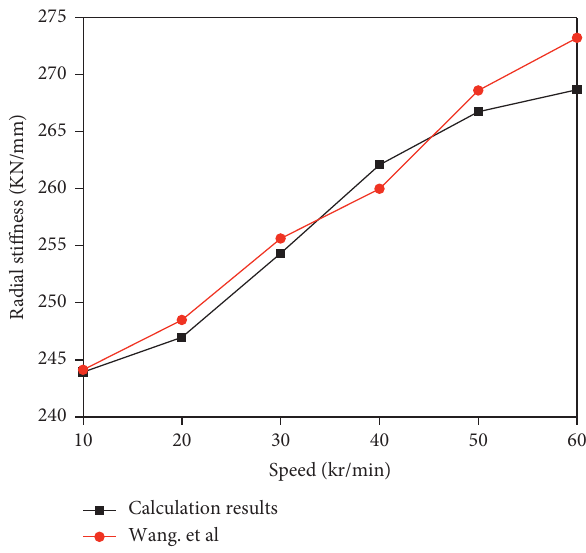
Figure 7: Comparison of two different models.